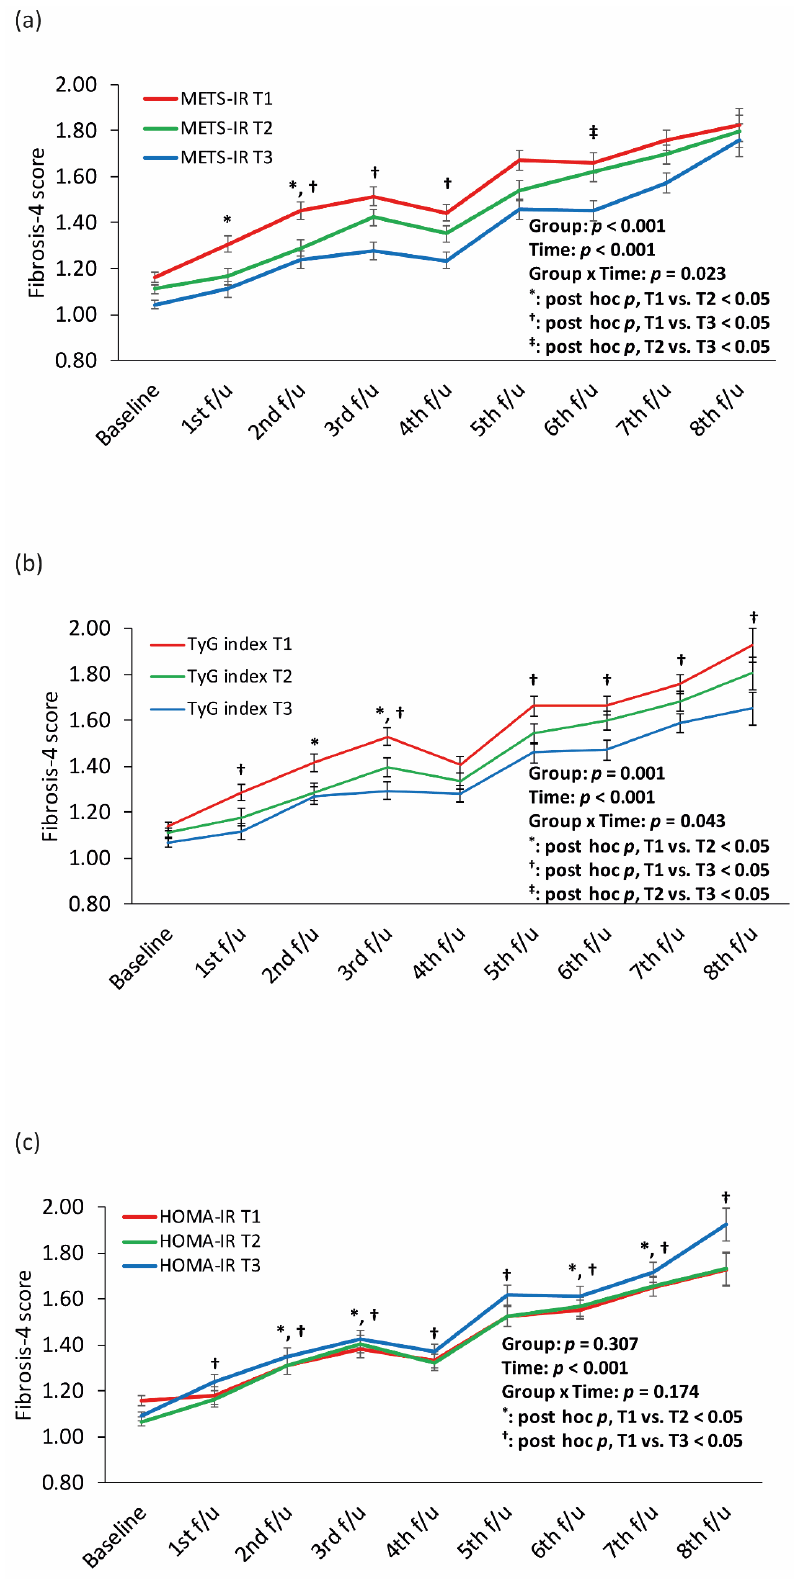
Figure 3. Longitudinal changes in the FIB-4 score according to the tertiles of ( a ) METS-IR, ( b ) the TyG index, and ( c ) HOMA-IR. Abbreviation: FIB-4, fibrosis-4; METS-IR, metabolic score for insulin resistance; TyG, triglyceride-glucose; HOMA-IR, homeostatic model assessment for insulin